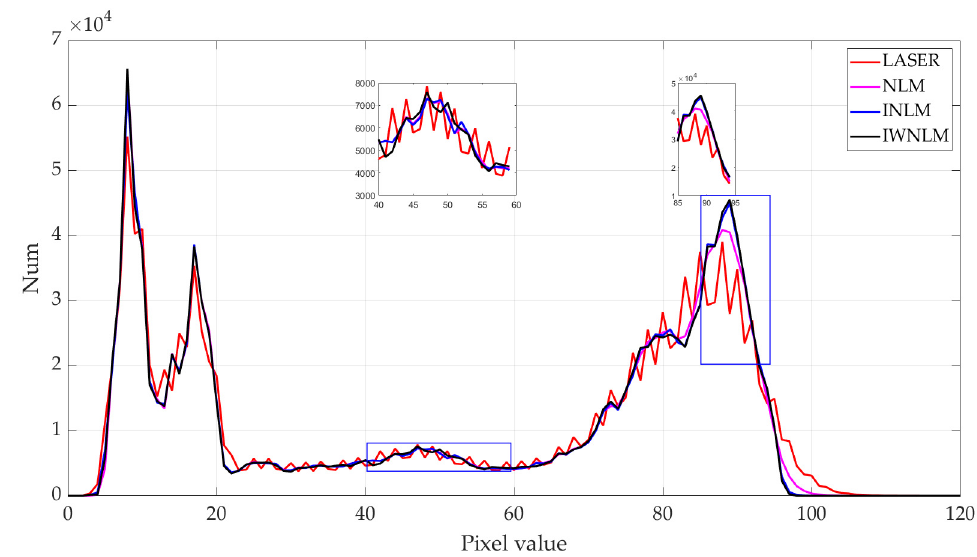
Figure 12. Histogram distribution of laser image and filtered images.